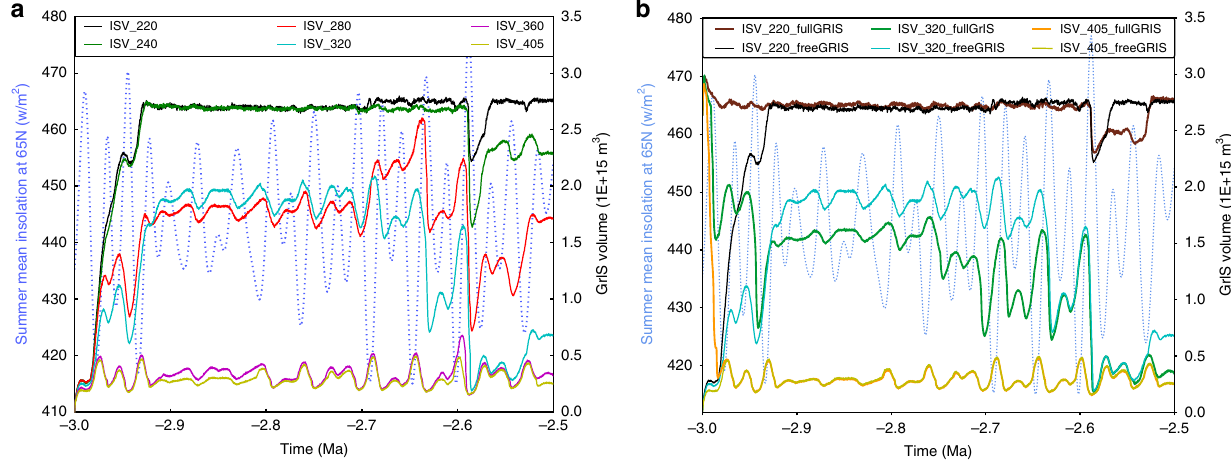
Fig. 1 Sensitivity tests with constant pCO 2 scenarios. a Simulated GrIS volume (ISV on the fi gure) with various constant pCO 2 concentrations (220 ppmv, 240 ppmv, 280 ppmv, 320 ppmv, 360 ppmv, 405 ppmv; so that ISV_220 indicates the simulated GrIS with constant pCO 2 of 220 ppmv). b Simulated GrIS volume with the three pCO 2 concentrations (220 ppmv, 320 ppmv and 405 ppmv under two different initial GrIS con fi gurations: the present-day full GrIS or an ice-free Greenland. Light blue dash lines represent the summer mean insolation at 65